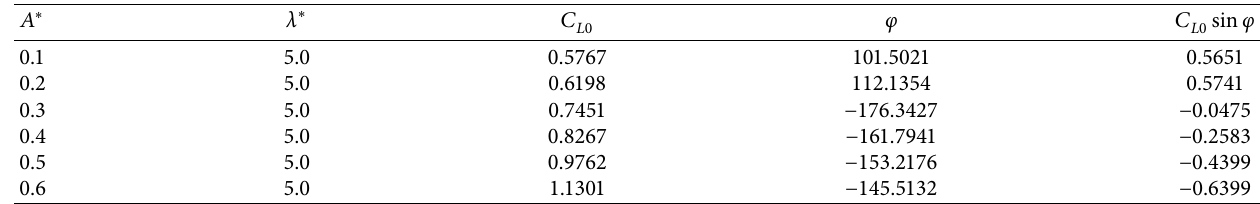
Table 8: Forced oscillating response at different amplitude ratio A ∗ at λ ∗ � 5 . 0.